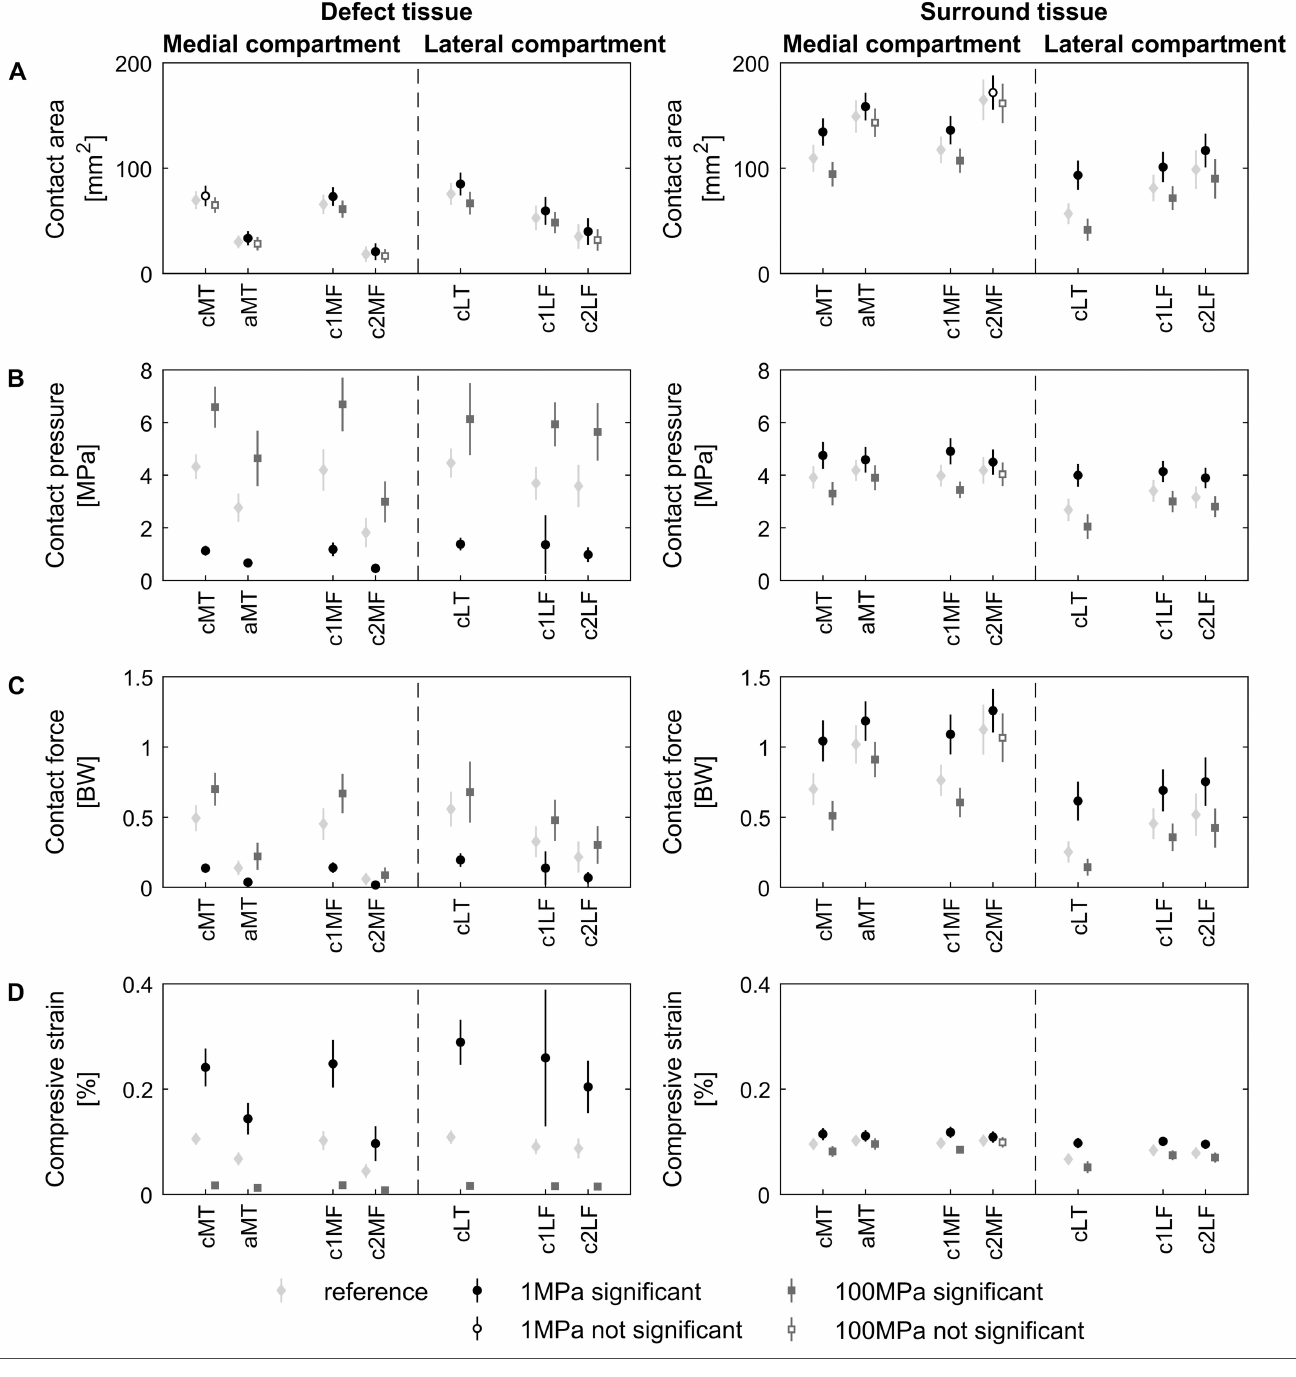
Fig 6. Average load distribution of defect and surrounding tissue throughout stance phase of gait. Average contact area (A), contact pressure (B), contact force (C) and compressive strain (D) inside and surrounding the defect for defect locations that presented significant differences in average contact area and pressure at compartmental level throughout the stance phase of gait (Fig 1 and Fig 3). The light-gray, black and dark-gray error bars represent the reference simulation, cartilage softening (1MPa) and hardening (100MPa) at the defect location, respectively (n = 30). Filled markers indicate significant differences compared to the reference simulation (light-gray error bar) at 5% significance